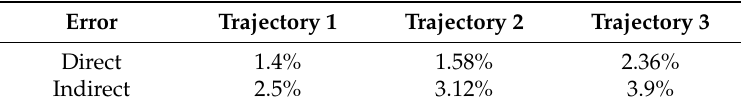
Table 2. Position errors.